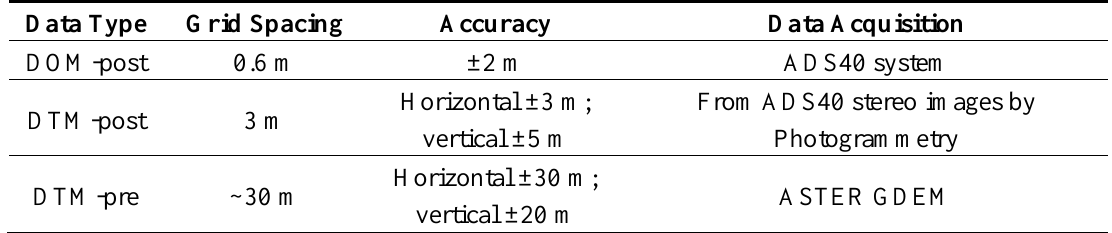
Table 1. Basic information about the Digital Orthophoto Map (DOM) and digital terrain models (DTMs) and their accuracy.